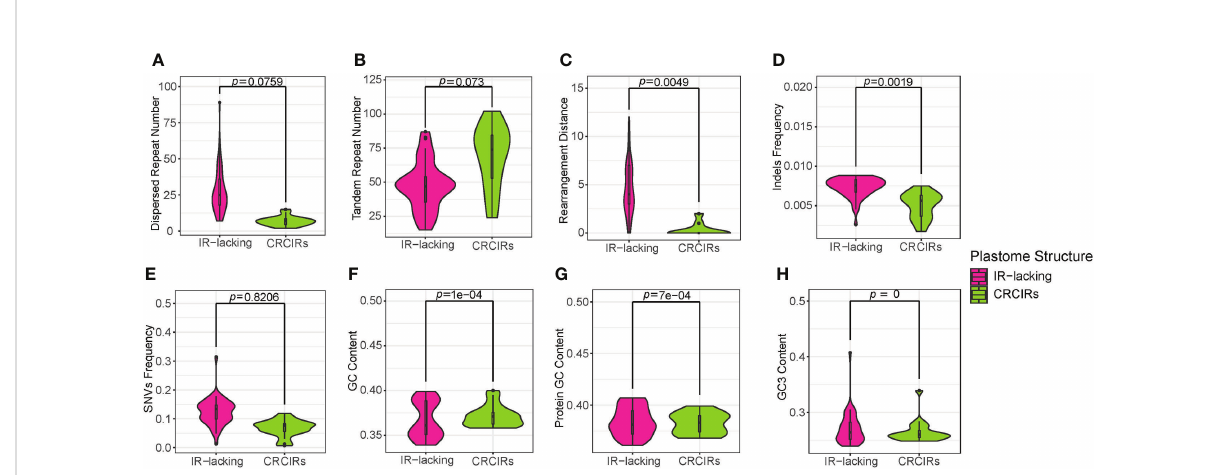
FIGURE 1 Violin plots for comparisons of eight variables between IR-lacking plastomes and those of their CRCIRs with phylogenetic t-test. (A) dispersed repeat number; (B) tandem repeat number; (C) rearrangement distance; (D) indels frequency; (E) SNVs frequency; (F) whole plastome GC content; (G) protein-coding genes GC content; (H) GC3